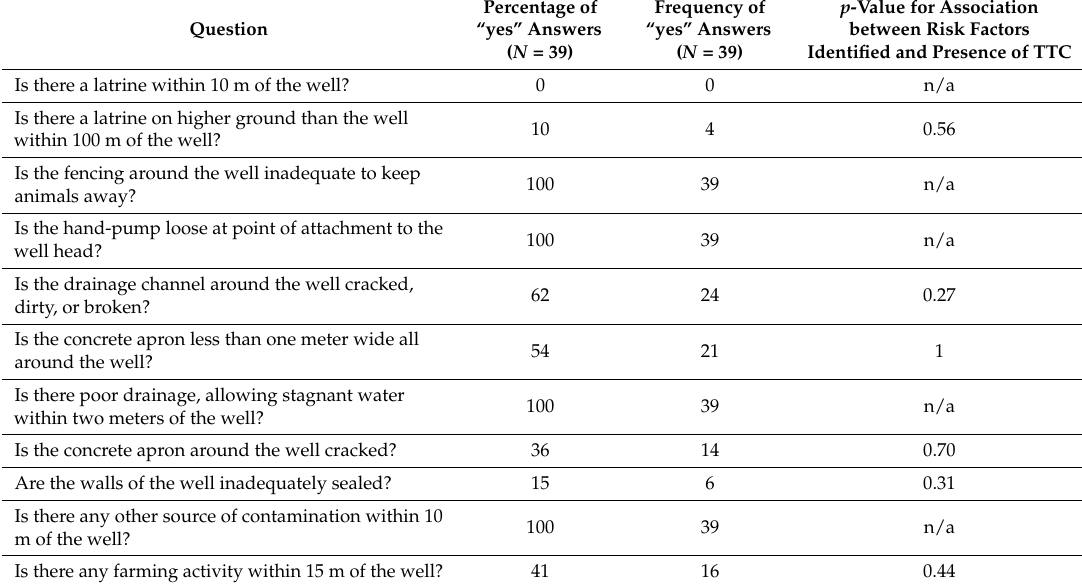
Table 3. The results of sanitary survey and Fisher’s exact test results for association between risk factors identified and presence of TTC for covered wells for field study 2. Question